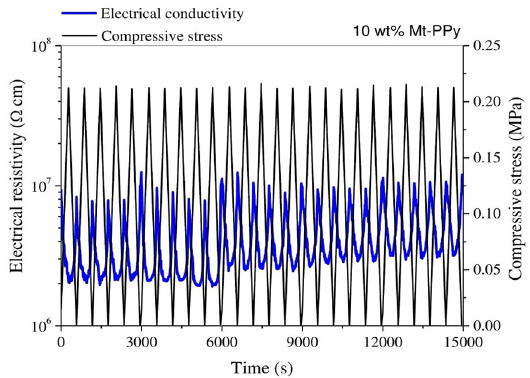
Figure 9. Electrical resistivity as a function of 25 compressive loading-unloading stress cycles on PBAT/Mt- PPy, filled with 10 wt% of Mt-PPy.